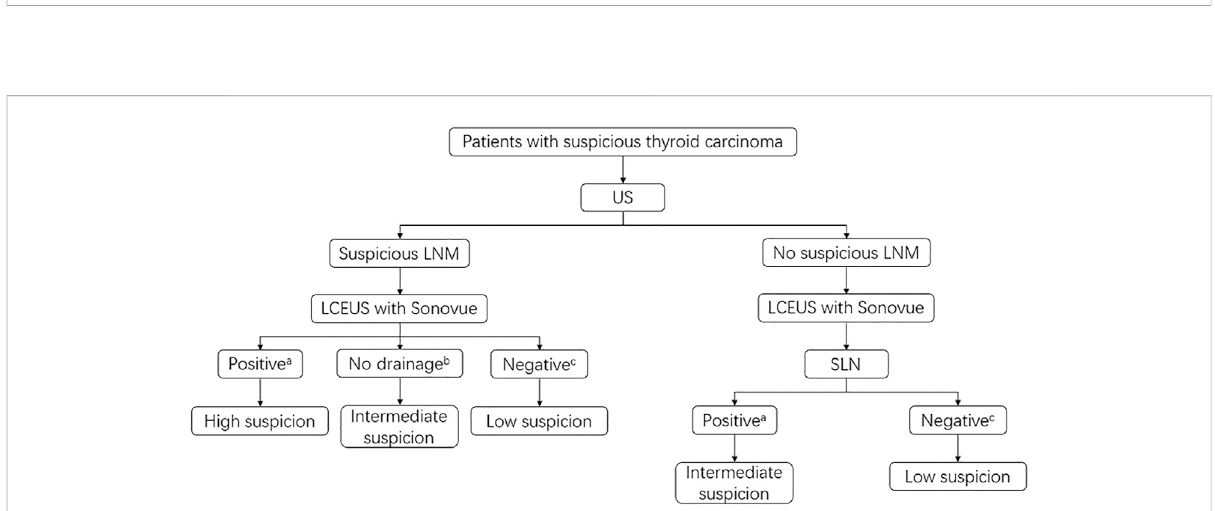
FIGURE 4 Recommended clinical work fl ow of LCEUS with SonoVue in the LNM detection and management. a Positive means perfusion defect or no perfusion on LCEUS; b No drainage means no enhanced lymphatic vessels around the suspicious LNM area; c Negative means complete perfusion or complete ring sign on LCEUS. High suspicion: Lymph node biopsy or resection if a biopsy is not operable is recommended; Intermediate suspicion: Further examination such as intravenous CEUS or lymph node biopsy is recommended; Low suspicion: Conventional US follow-up is